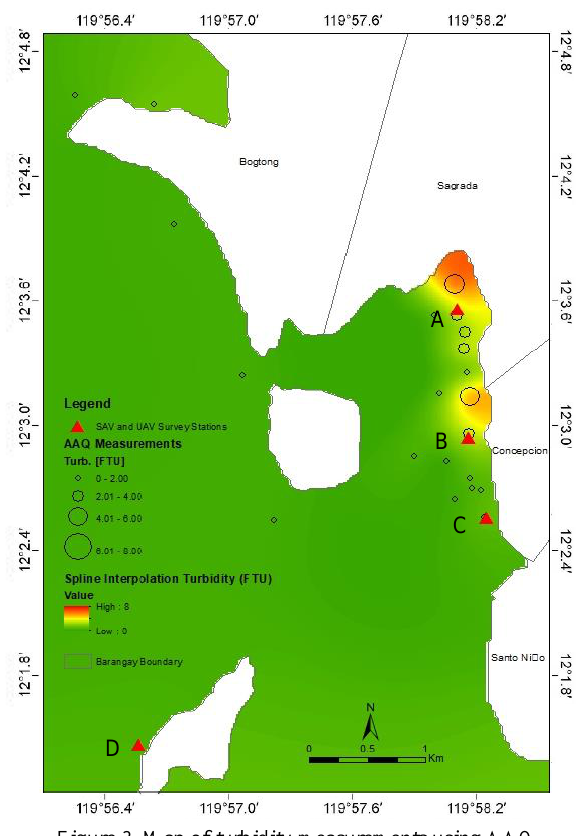
Figure 3. Map of turbidity measurements using AAQ